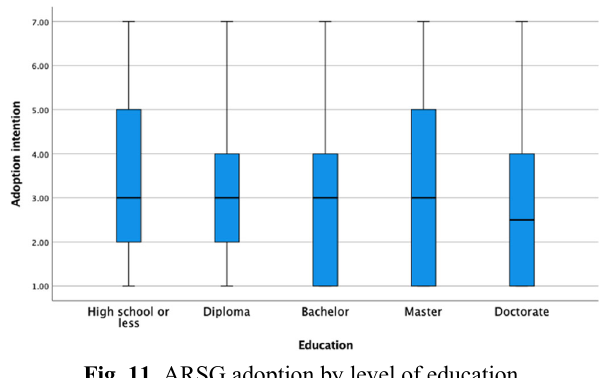
Fig. 11. ARSG adoption by level of education